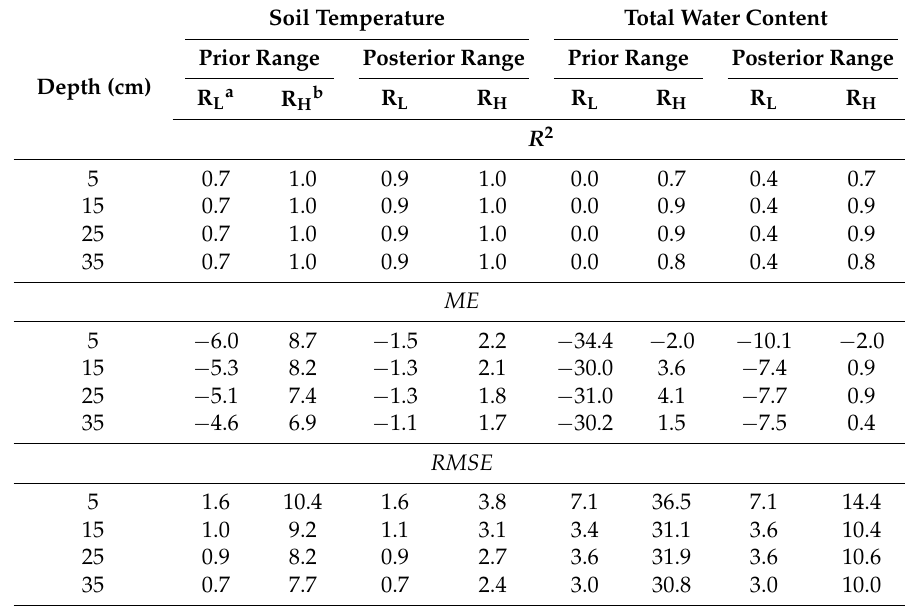
Table 3. Prior and posterior ranges for soil temperature and total water content at various